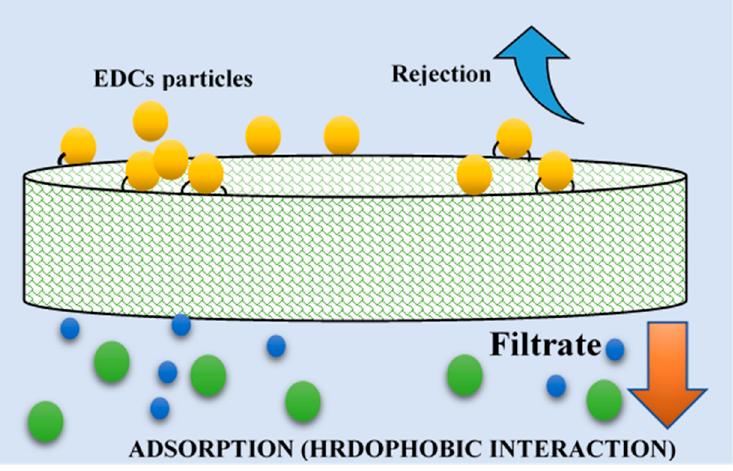
Figure 3. Adsorption (hydrophobic interaction) adapted with modification [128].